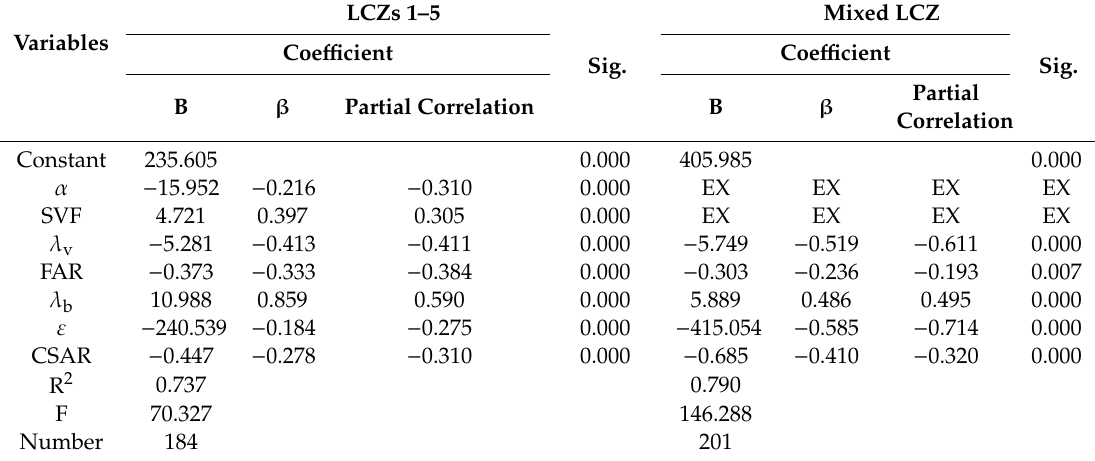
Table 3. The step-wise multiple regression results of the SUHI prediction